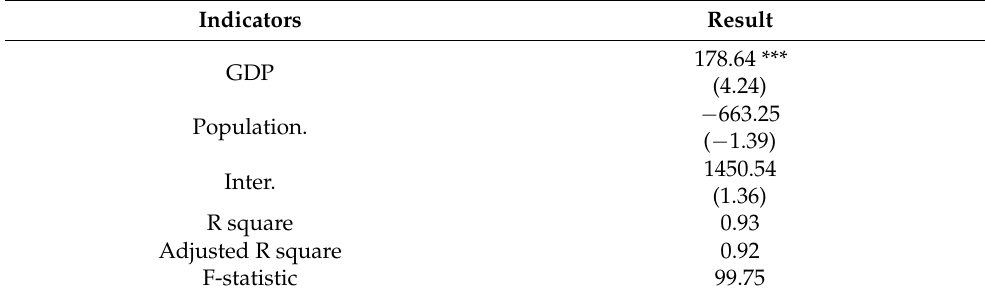
Table 5. Regression